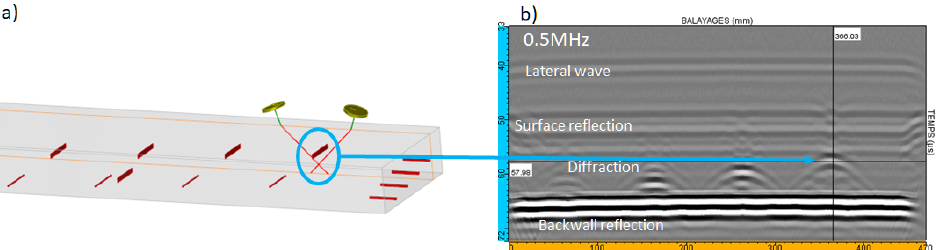
Figure 18. ( a ) S45°TOFD immersion inspection of several embedded planar electro eroded slots; ( b ) experimental BScan obtained when scanning the notches and the flat bottom holes at 0.5 MHz.